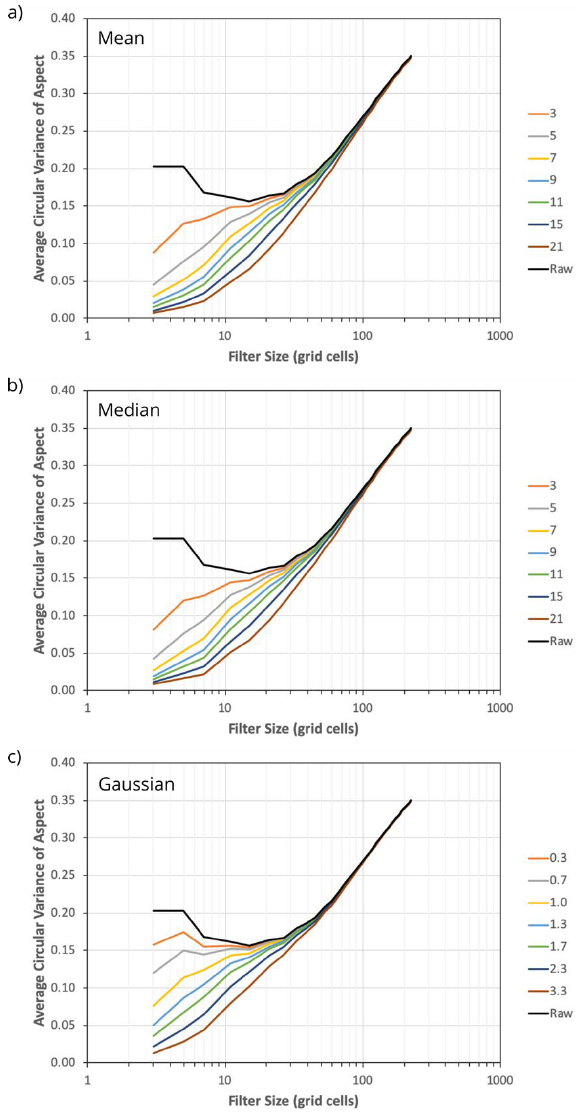
Figure 8. The effects of applying ( a ) mean, ( b ) median, and ( c ) Gaussian low-pass filters of varying sizes on the CVA scale signature of the study site DEM. Filter kernel sizes are each expressed in grid cells. The Gaussian filter kernel size is a function of the sigma-parameter value.